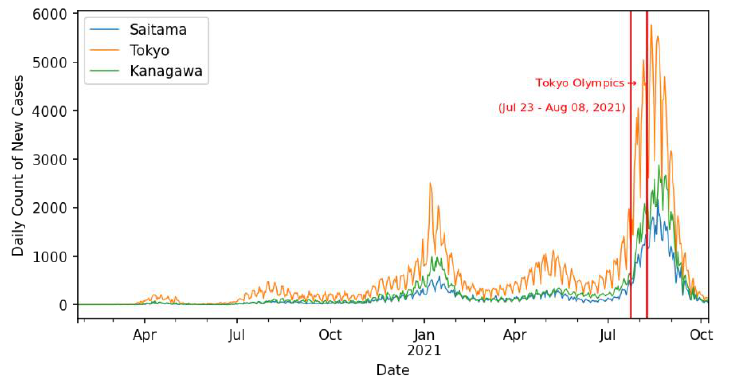
Figure 9. Daily count of new cases in Tokyo and surrounding prefectures for data until 8 October 2021.